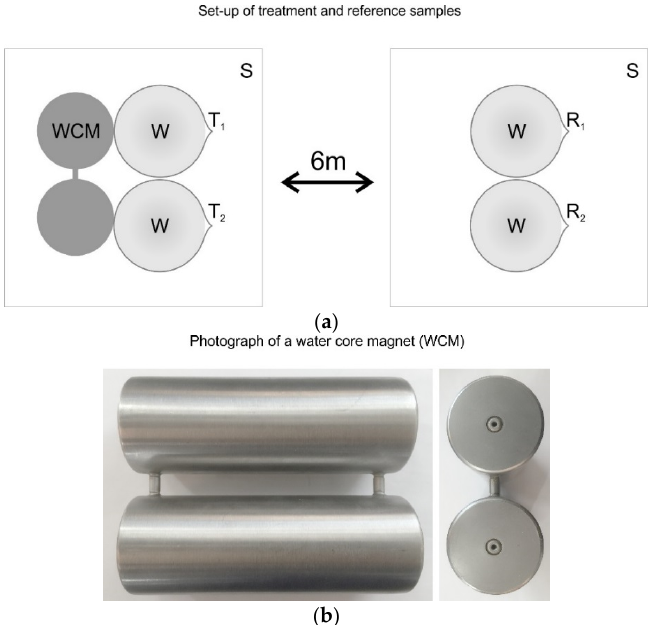
Figure 2. ( a ) Sketch showing the set-up for the treatment and the reference; S: plastic base (table), WCM: water core magnet, W: watch glass covering the beakers, T: treated beakers, R: reference beakers. ( b ) Water core magnet treatment device type DZKL (cylinder radius 2.25 cm, height 15 cm, distance between cylinders 1 cm)